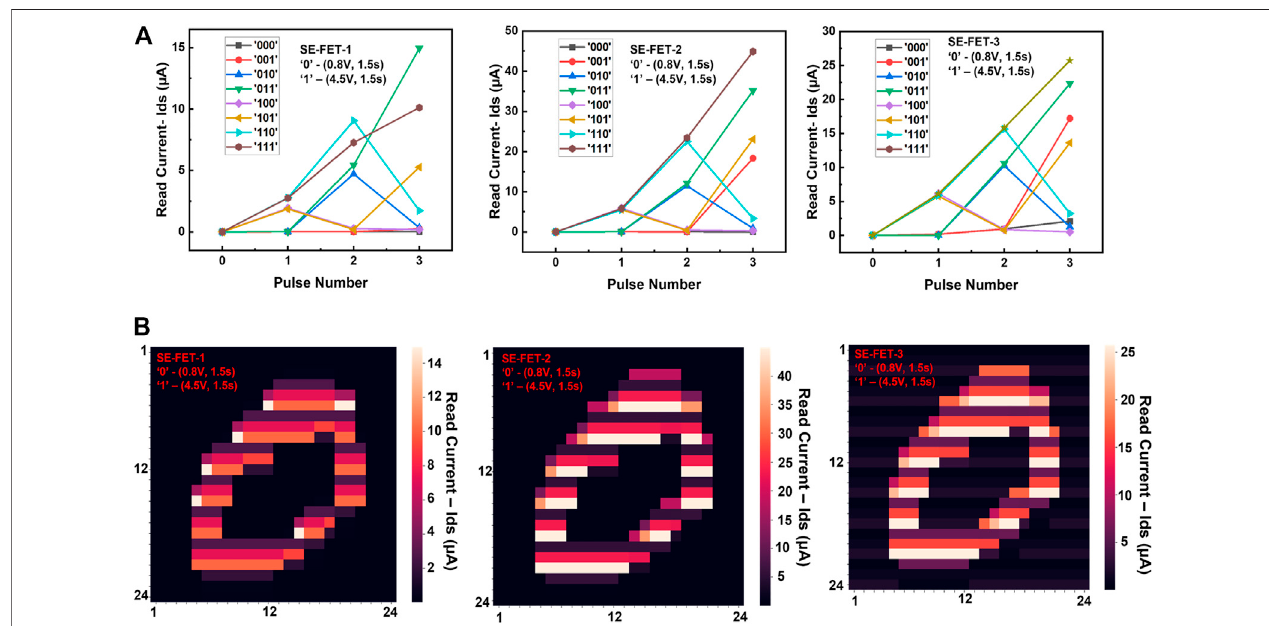
FIGURE4| SE-FETresponsetotemporalinput. (A) TheresponseofthreedifferentSE-FETdevices,whensubjectedtoallpossibleeightcombinationsoftemporal inputs, show similar trends as well as a device-to-device variability with the same gate voltage for each device. (B) The heatmap shows the complete recorded output response of digit 0 for three different devices. The scale on the right of each fi gure shows the difference in magnitude of the read current for the same input for different devices. This variability increases the reservoir dimensionality.